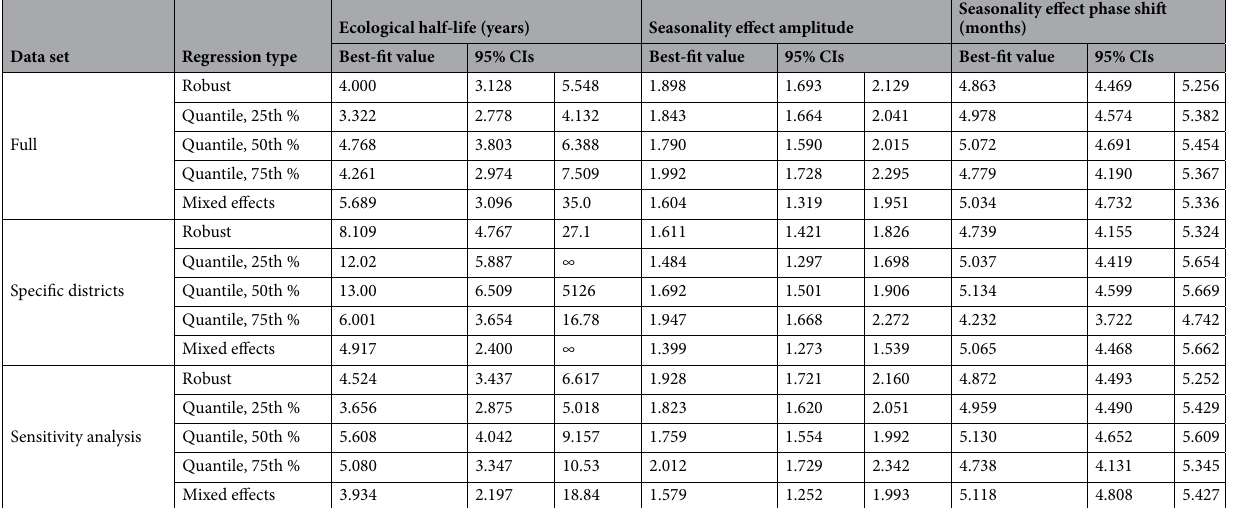
Table 5. Summary metrics for robust, quantile and mixed-effects fits of our model (Eq. 1A, 1B) to wild boar data. In this and the following tables, infinite values for the ecological half-life of radioactive cesium indicate instances where the uncertainty on the corresponding model parameter µ extended to negative values. Sensitivity analysis represents analysis of a subset of data collected ≥ 6 months after the Fukushima accident, and where Aizu and Minamiaizu districts were